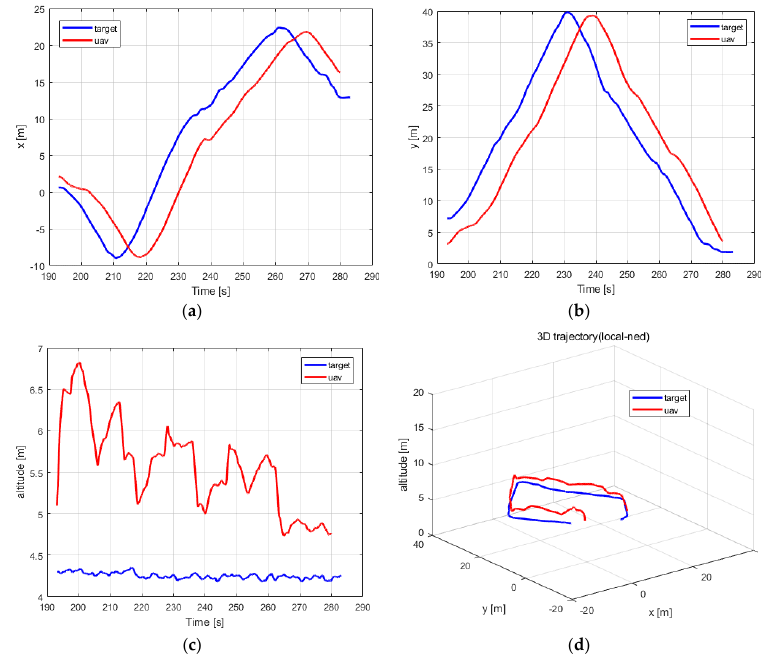
Figure 21. The actual position ( a – c ) and 3D trajectory ( d ) of the UAV and the target drone in the local NED frame.